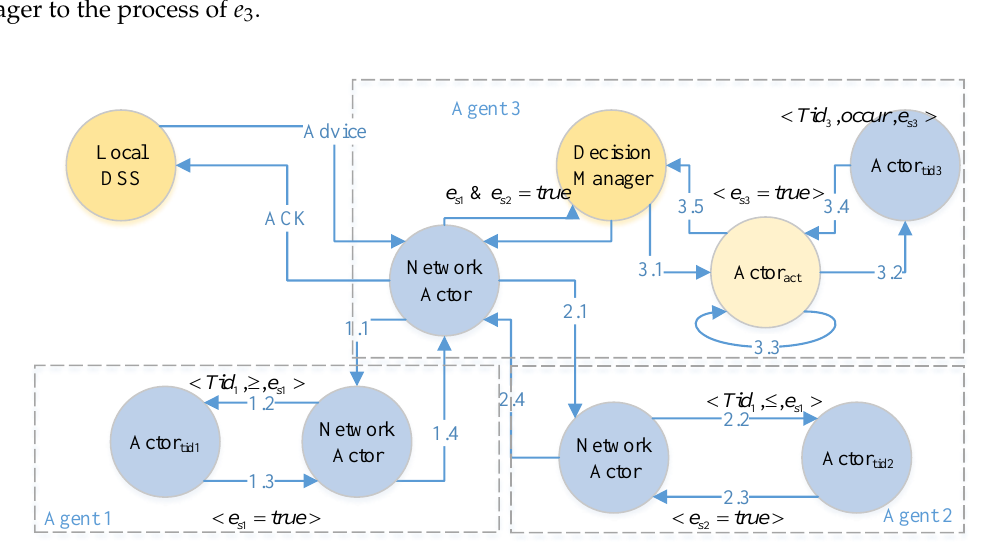
Figure 9. A possible solution for traditional centralized decision process.